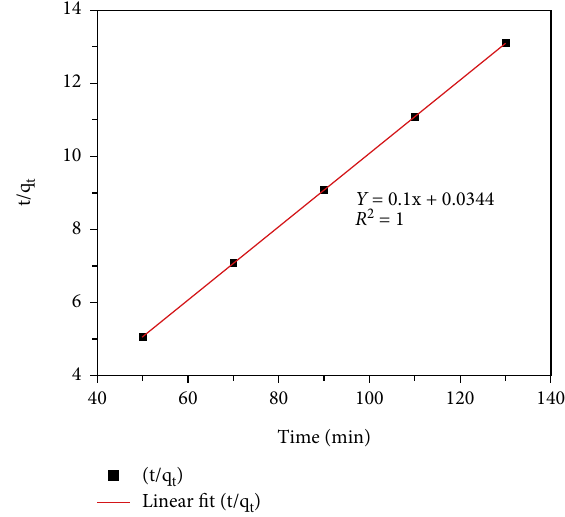
Figure 16: Second-order kinetics model for adsorption of Pb (II) on CMNB at pH of 6, initial concentration of 100mg/L, and adsorbent dosage of 0.9 g\L.